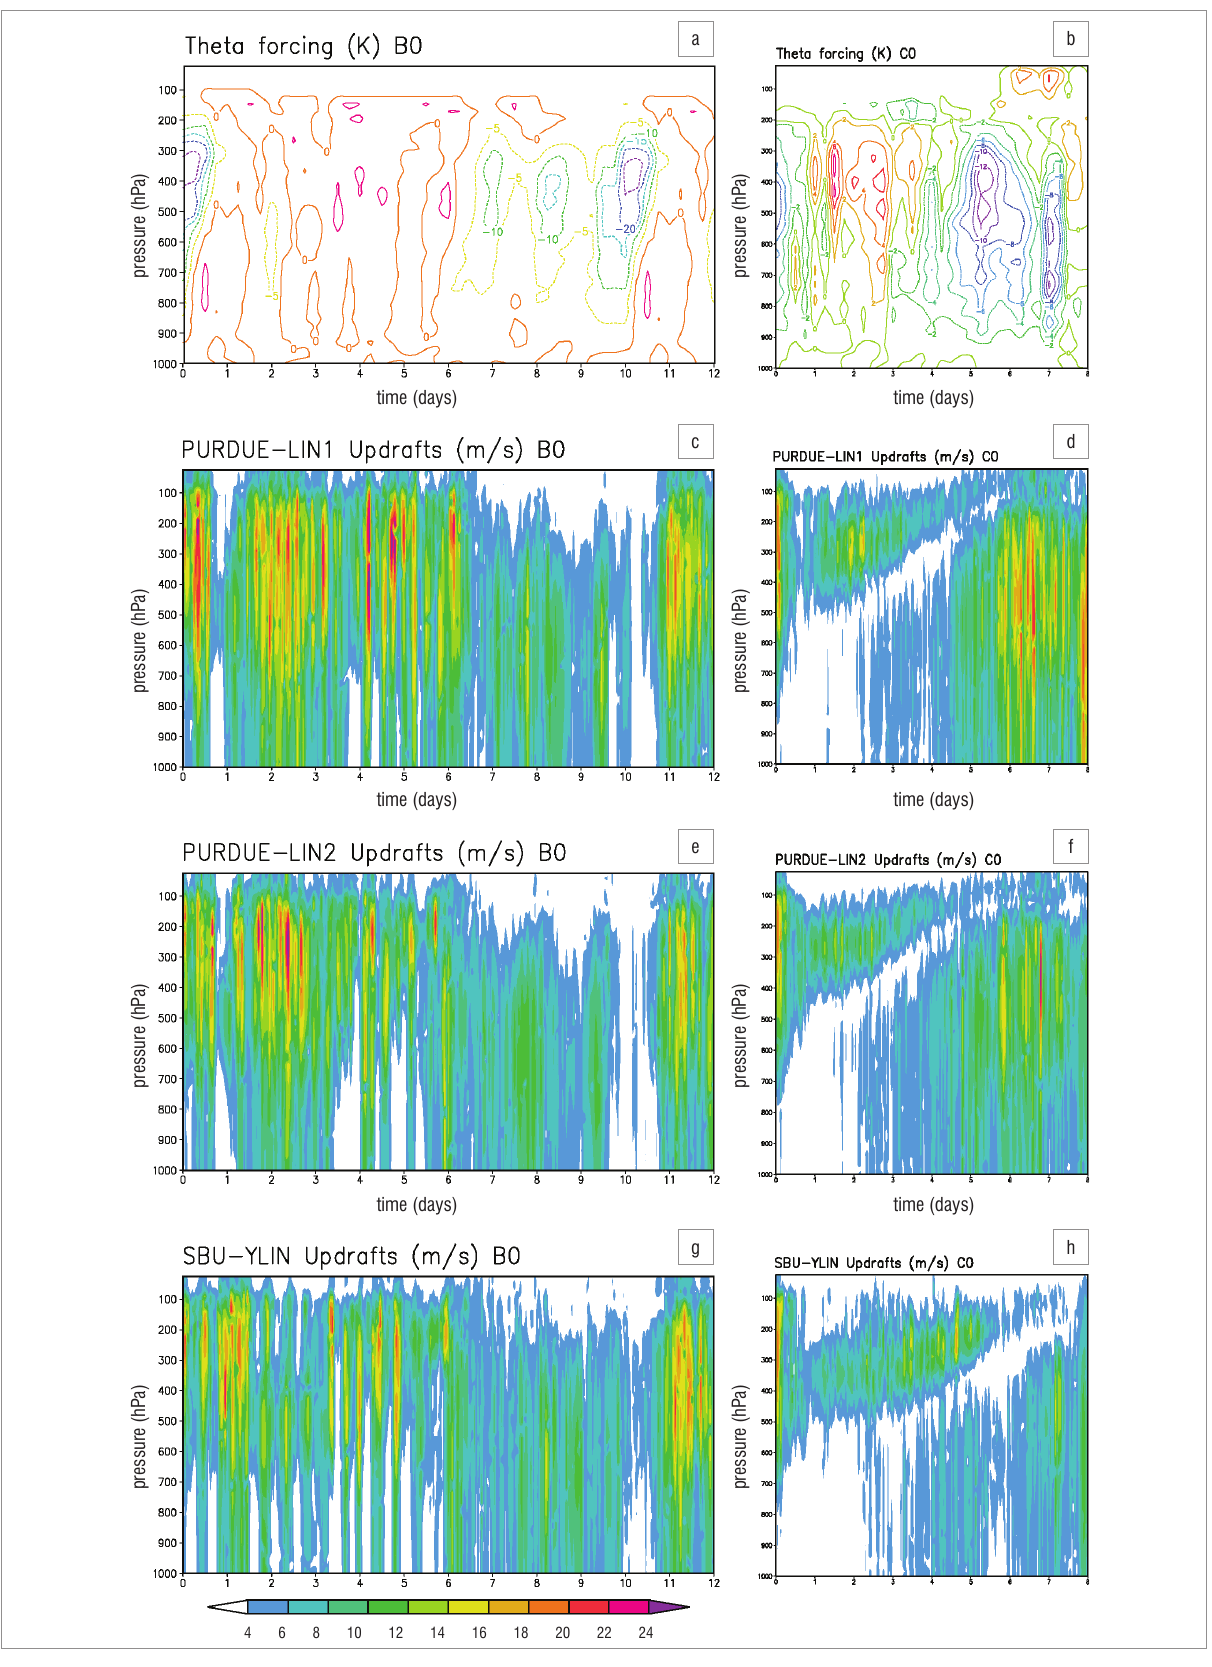
Figure 6: The temporal evolution of the large-scale warming and cooling in the (a) B0 and (b) C0 experiments. The temporal evolution of the simulated maximum updrafts across the domain by the different schemes (a,c,e) over a 12-day period for the B0 experiment and (b,d,f) 8-day period for the C0